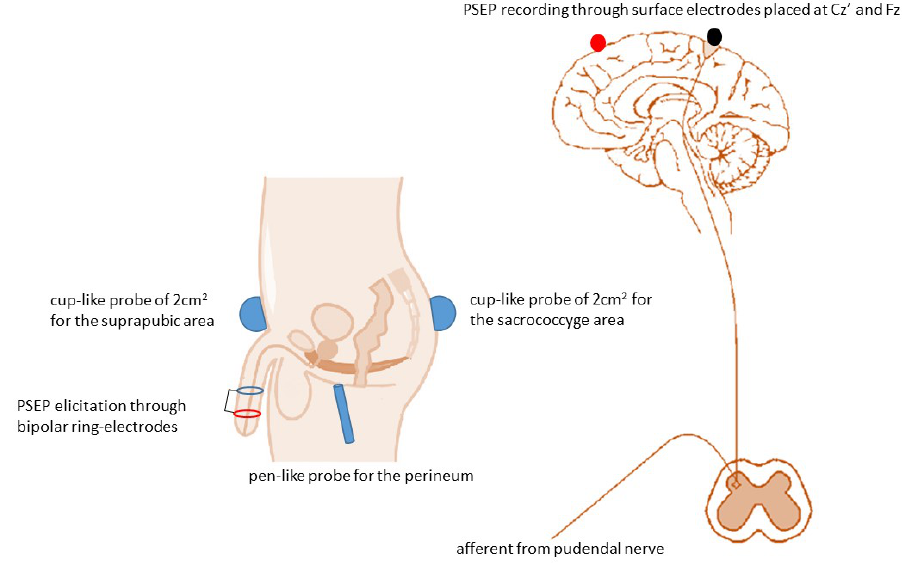
Figure 2. Placement of the suprapubic and perineum probes prior to body fixation by Velcro-straps.